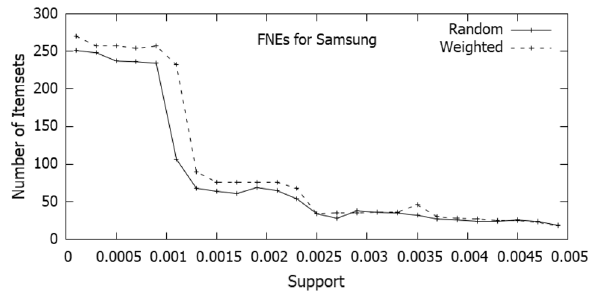
Fig. 8 Average number of itemsets for Samsung